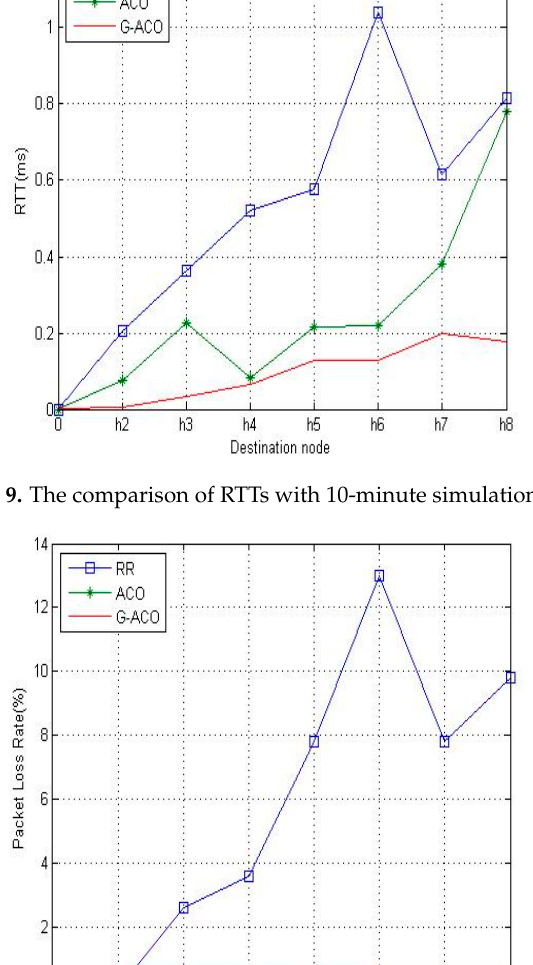
Table 6. The selected path with the three